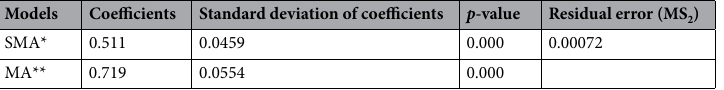
Table 7. The statistical analysis of the SARIMA ( 0,1,1 ) × ( 0,1,1 ) model. *SMA model implies the SARIMA